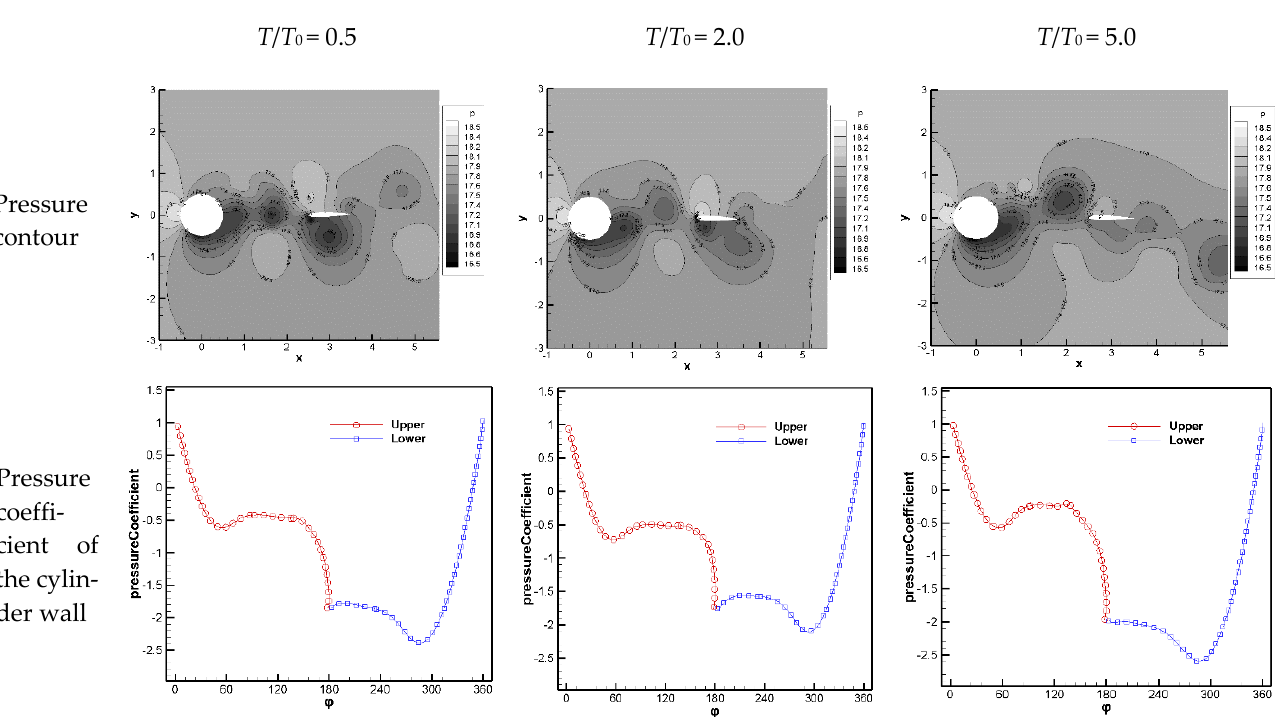
Figure 9. Vorticity contour at the moment of drag coefficient amplitude ( x / D = 1.0): ( a ) T / T 0 = 2.0; ( b ) T / T 0 = 5.0.